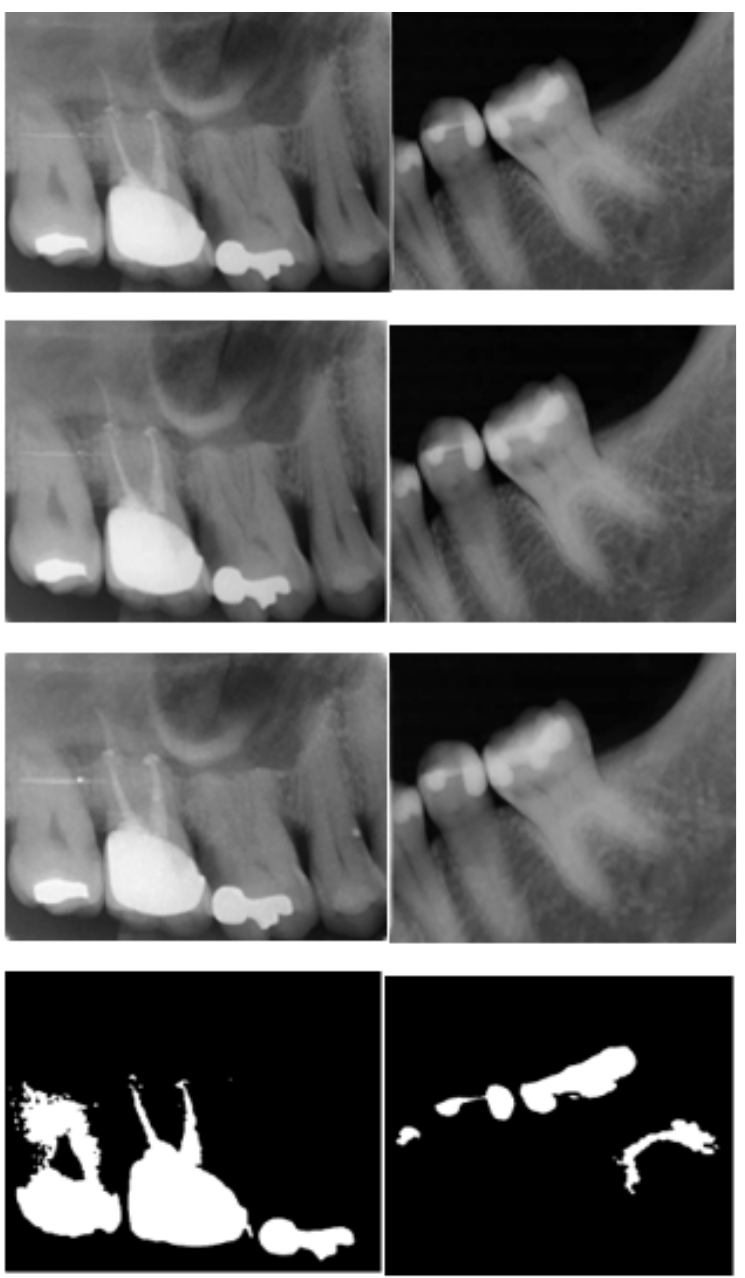
Figure 2. First Row : Original Gaussian blurred image. Second Row : Images after Erosion morphol- ogy. Third Row : Images after Dilation morphology. Fourth Row : Masked threshold image after connected component analysis via the eight-way kernel clustering